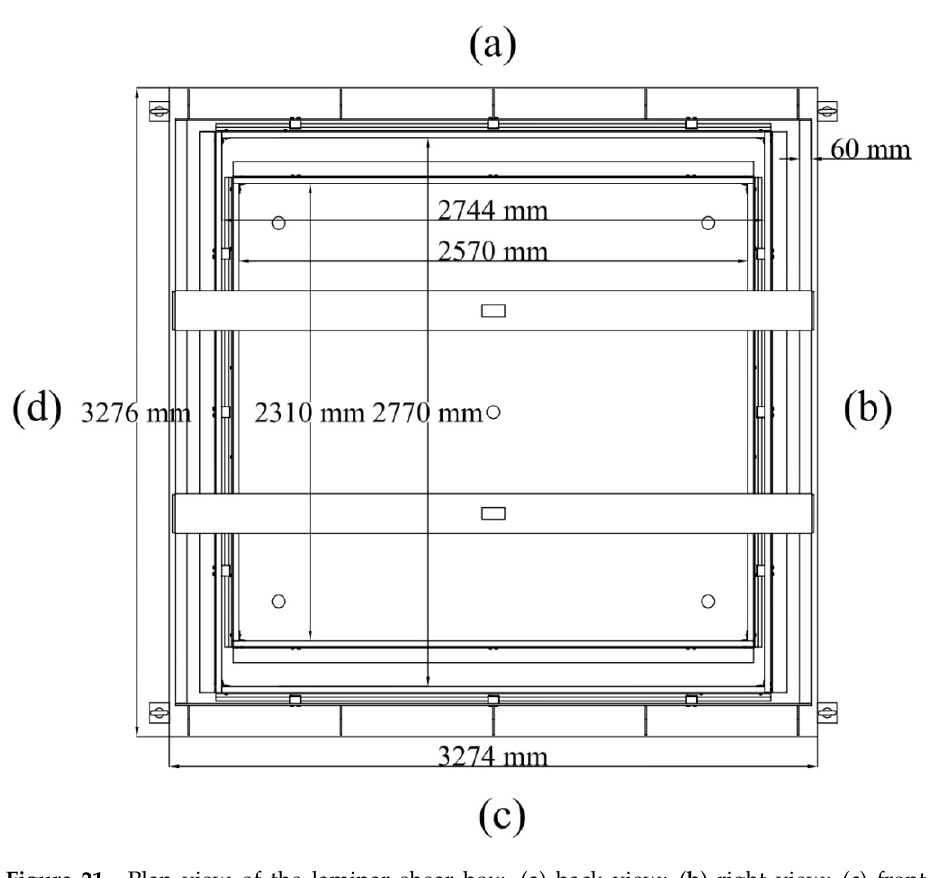
Figure 21. Plan view of the laminar shear box: ( a ) back view; ( b ) right view; ( c ) front view; ( d ) left view.